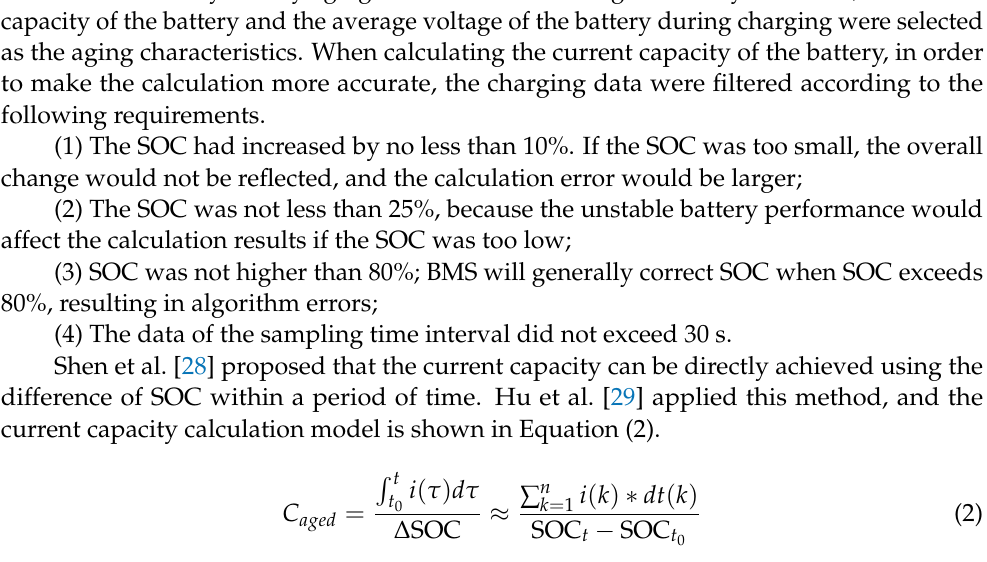
Figure 5. Average daily temperature from May 2019 to September 2020.